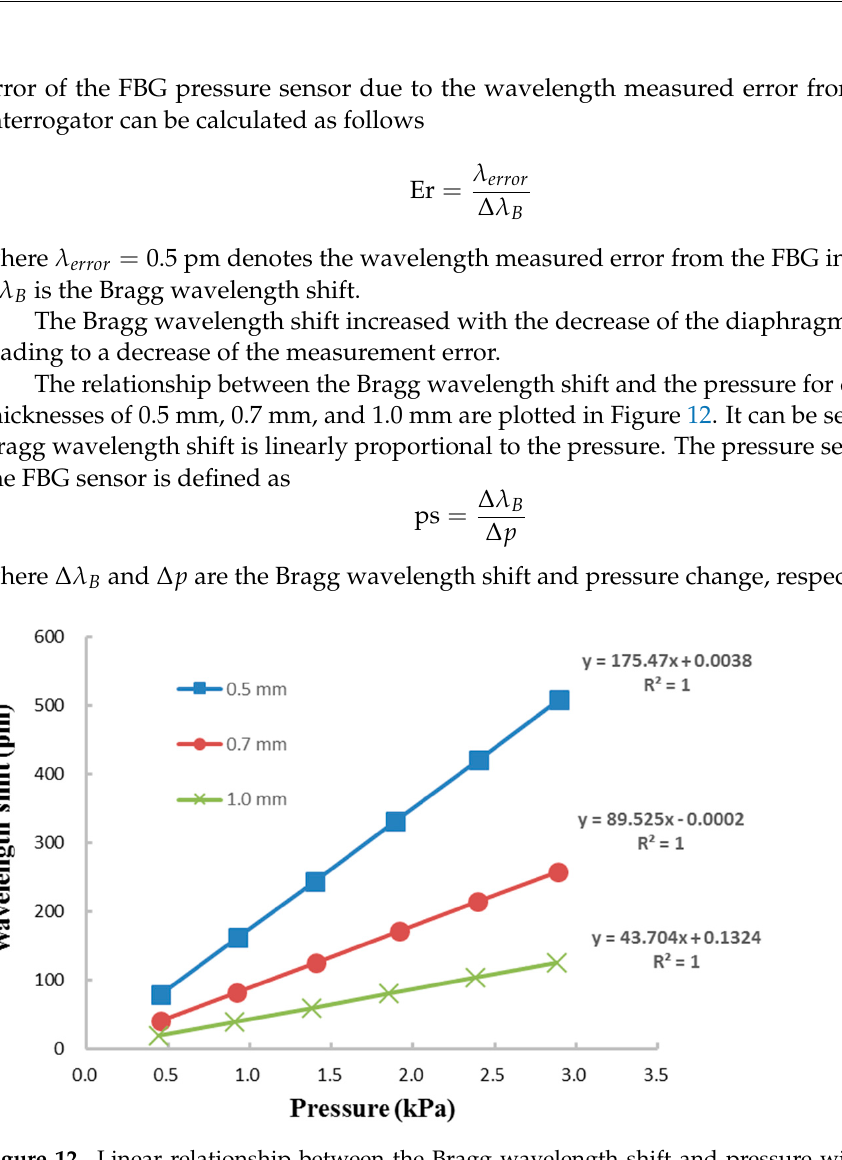
Figure 12. Linear relationship between the Bragg wavelength shift and pressure with different diaphragm thicknesses of 0.5 mm, 0.7 mm and 1.0 mm. diaphragm thicknesses of 0.5 mm, 0.7 mm and 1.0